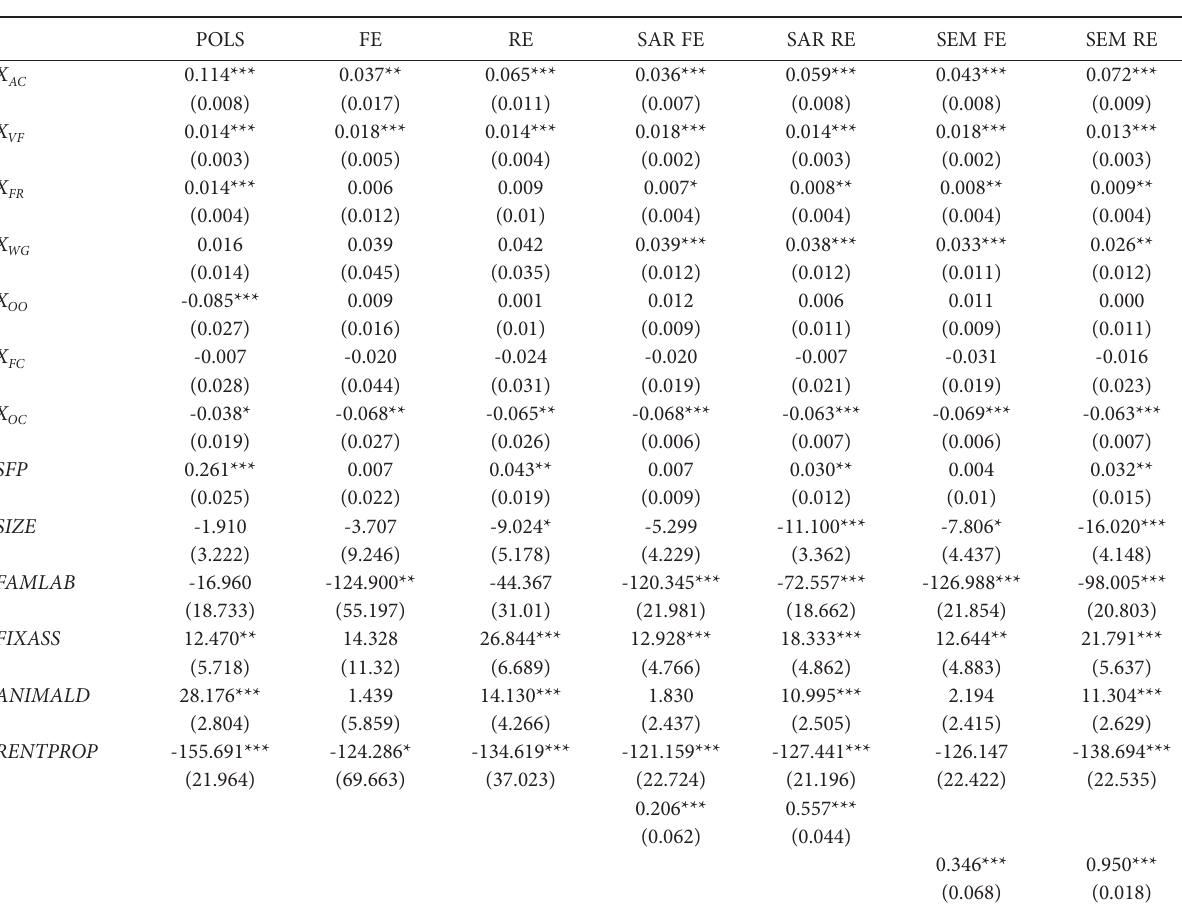
Table 3. Estimates of the rental price equation, EU regions,